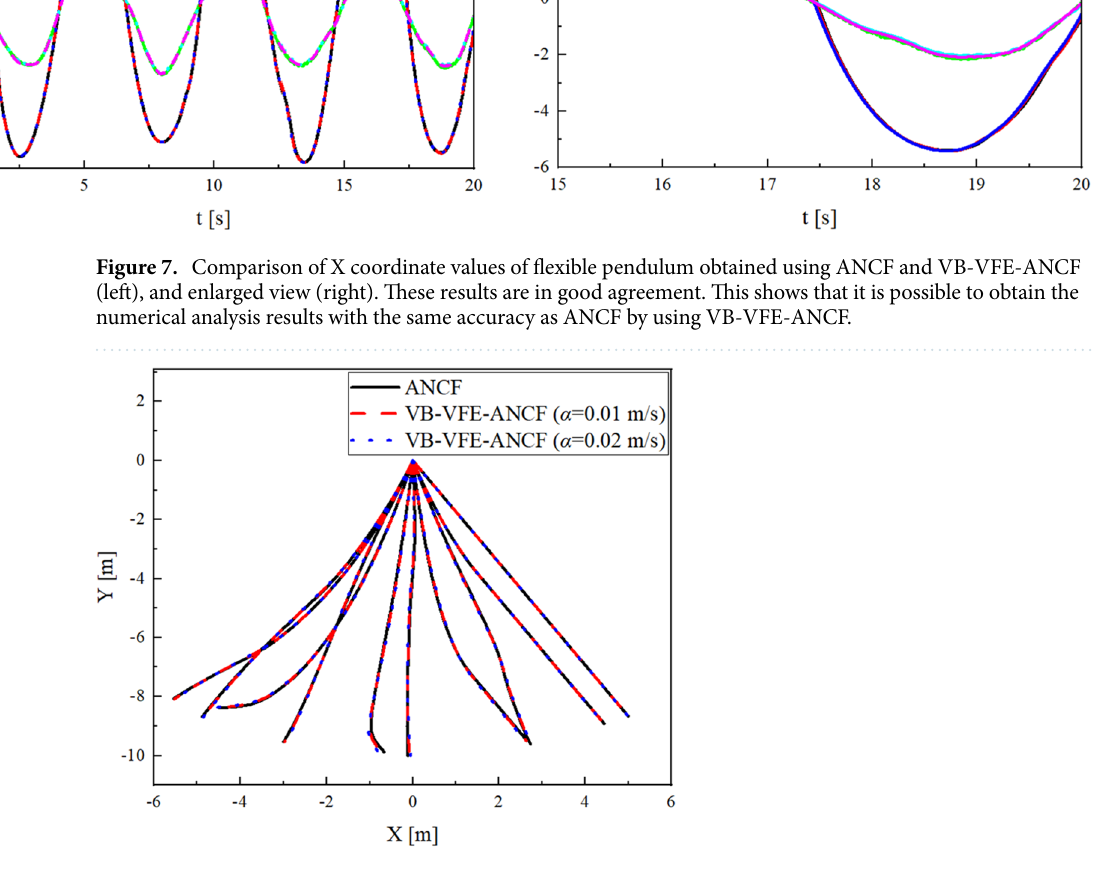
Figure 8. Comparison of the flexible pendulum shape obtained using ANCF and VB-VFE-ANCF for 5 s every 0.5